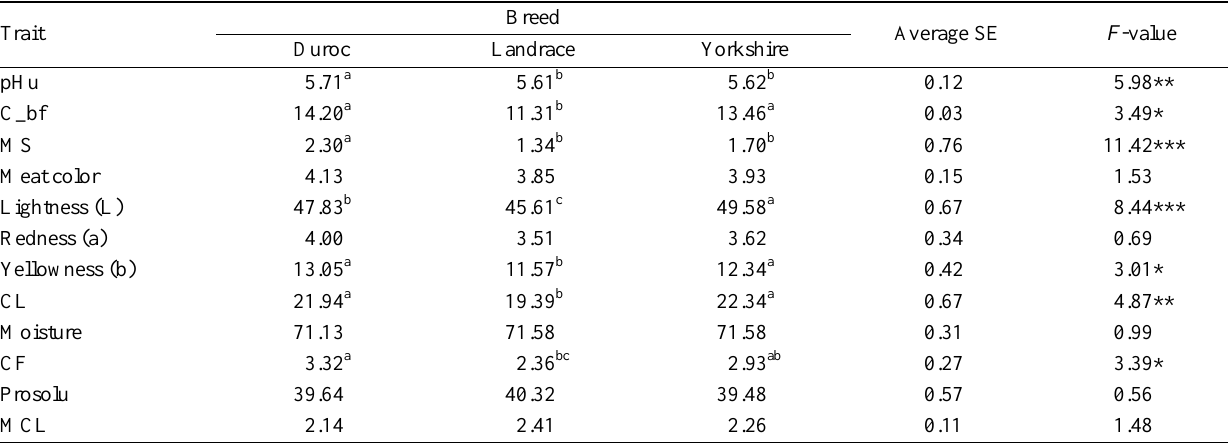
Table 2. Least square means demonstrating the effect of breed on meat characteristics